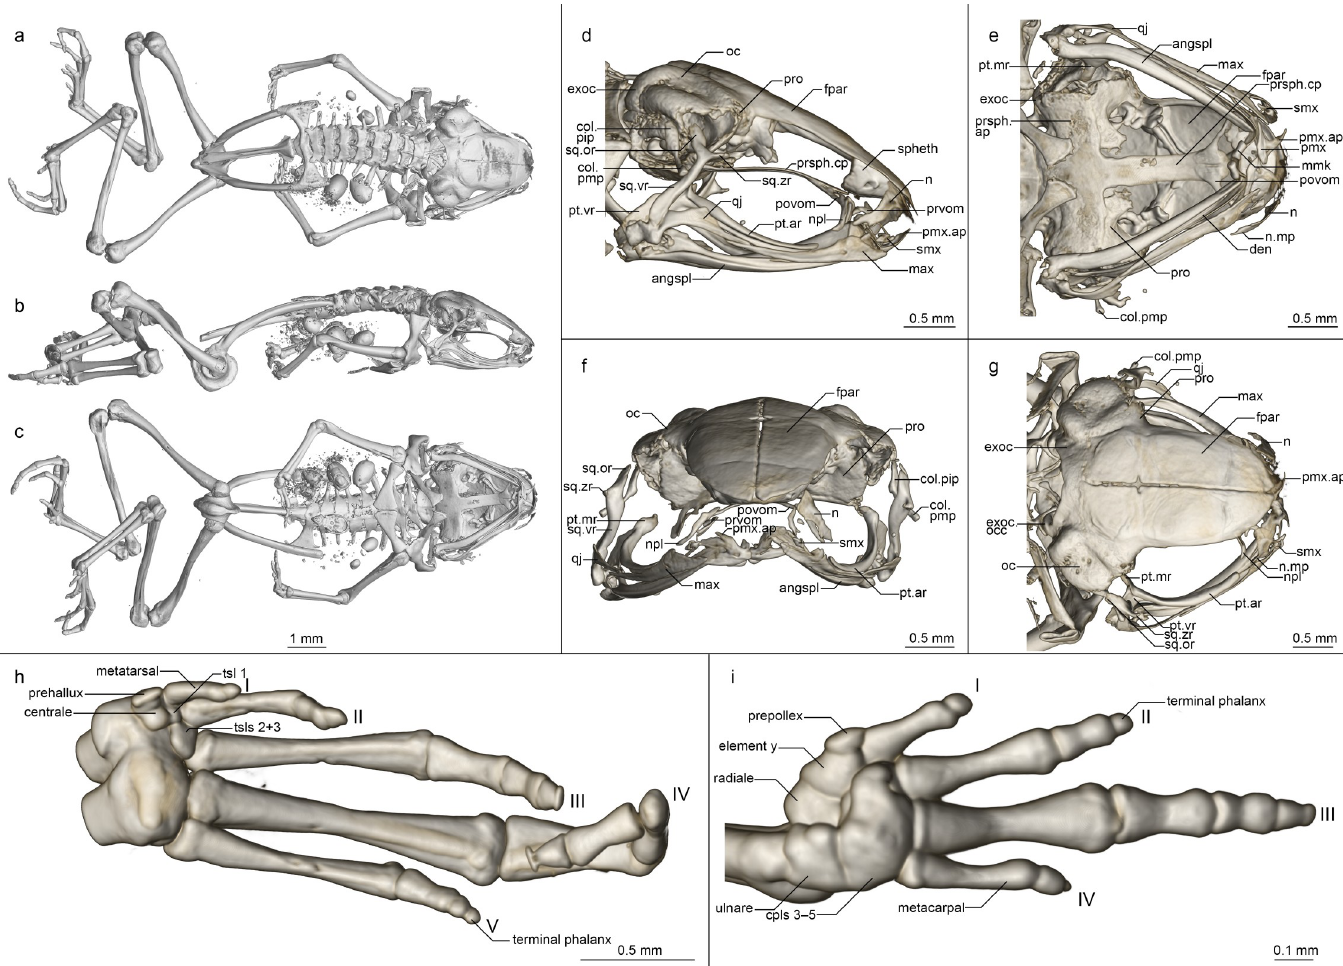
Fig 6. Osteology of Mini mum gen. et sp. nov. holotype (ZSM 861/2014). (a-c) Whole skeleton in (a) dorsal, (b) lateral, and (c) ventral view. (d-g) Skull in (d) lateral, (e) ventral, (f) anterior, and (g) dorsal view. (h) Foot in ventral view. (i) Hand in ventral view. Abbreviations for all osteological figures: angspl, angulosplenial; col.pip, pars interna plectra of columella; col.pmp, pars media plectra of columella; cpl(s), carpal(s); den, dentary; exoc, exoccipital; exoc.occ, occipital condyle of exoccipital; fpar, frontoparietal; max, maxilla; max.fp, facial process of maxilla; mmk, mentomeckelian; n, nasal; n.mp, maxillary process of nasal; npl, neopalatine; oc, otic capsule; prsph. ap, parasphenoid alary process; prsph.cp, parasphenoid cultriform process; prsph.pmp, parasphenoid posteromedial process; pmx, premaxilla; pmx.ap, premaxilla ascending process; pmx.lp, premaxilla lateral process; pmx.pp, premaxilla palatine process; povom, postchoanal portion of vomer; pro, prootic; prvom, prechoanal portion of vomer; pt.ar, pterygoid anterior ramus; pt.mr, pterygoid medial ramus; pt.vr, pterygoid ventral ramus; qj, quadratojugal; smx, septomaxilla; spheth, sphenethmoid; sq. or, squamosal otic ramus; sq.vr, squamosal ventral ramus; sq.zr, squamosal zygomatic ramus; tsl(s), tarsals; vt, vomerine teeth.